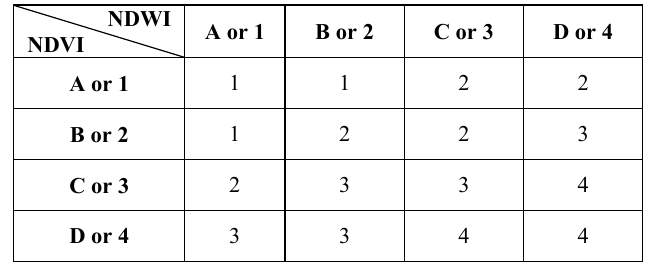
Table 1: Stratification of pixels on the basis of NDVI and NDWI